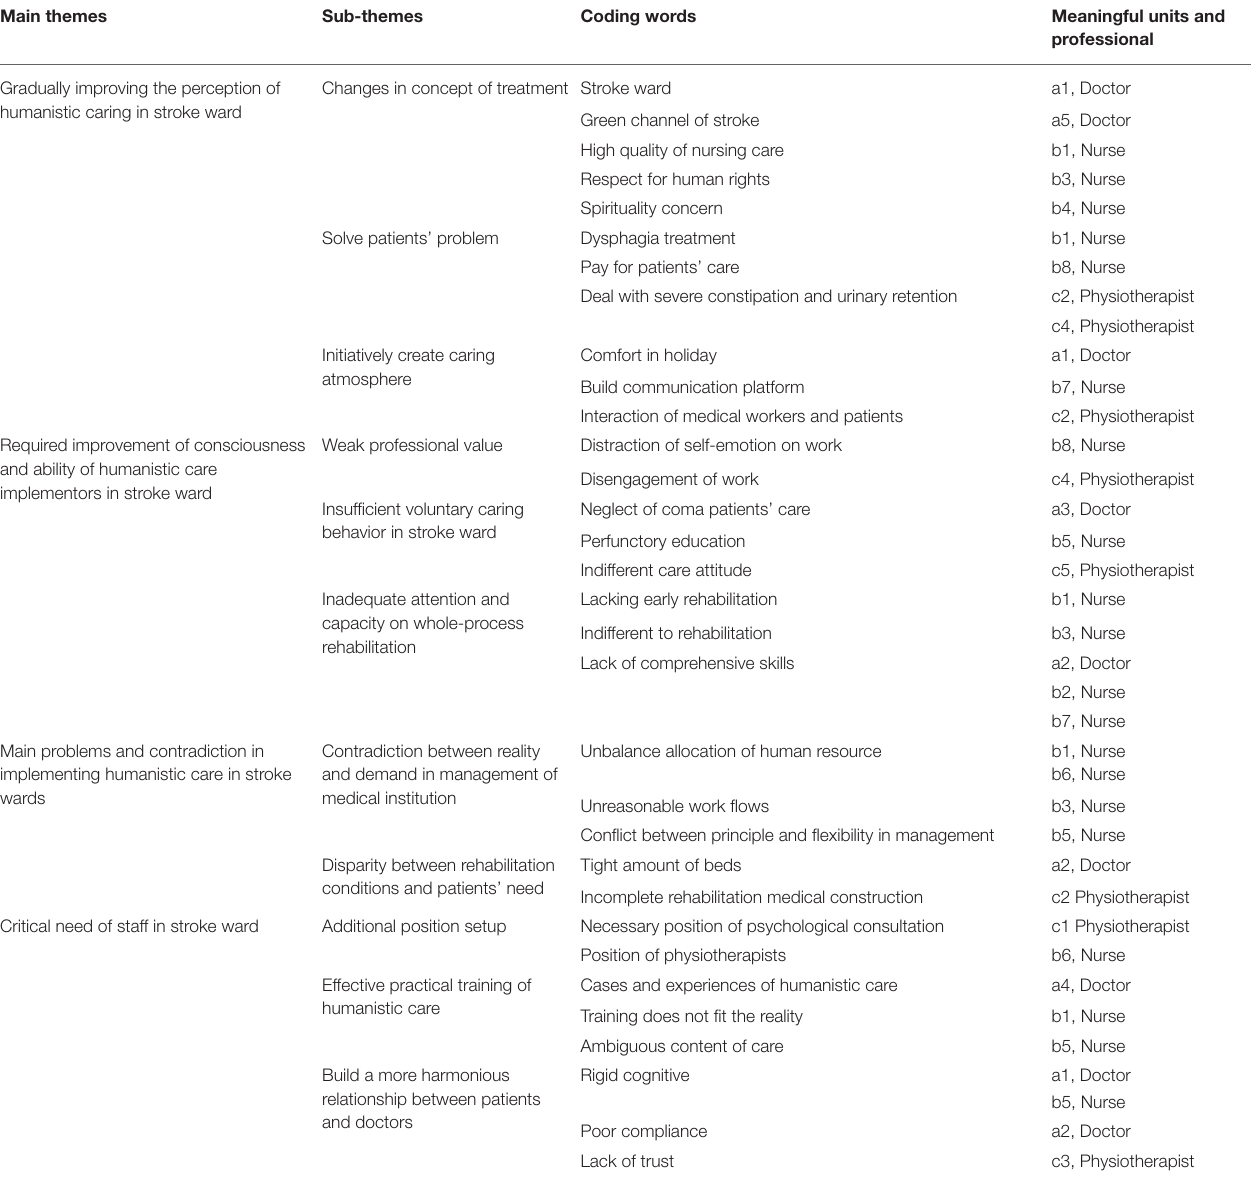
TABLE 3 | Summary of themes, coding words, and meaningful